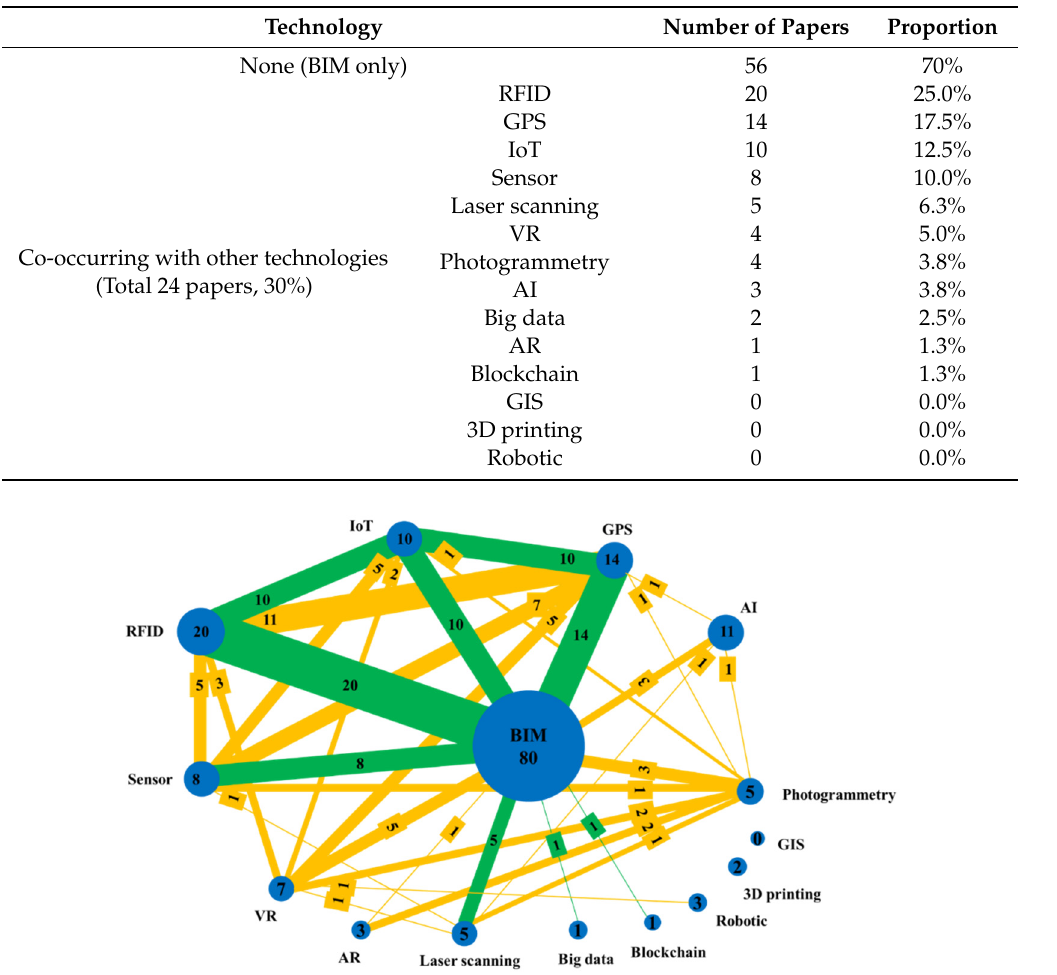
Table 2. Co-occurrence of building information modelling (BIM) with other digital technologies in BIM studies (total number of papers = 80).